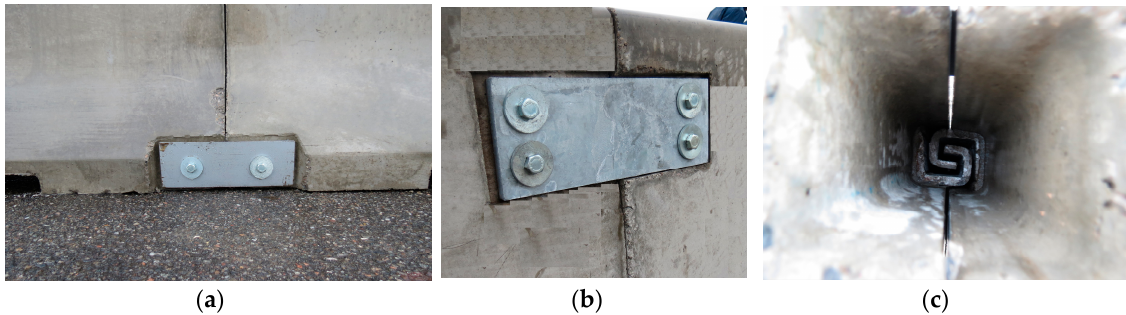
Figure 4. Concrete barrier connections: ( a ) lower, ( b ) rear, and ( c ) between blocks.